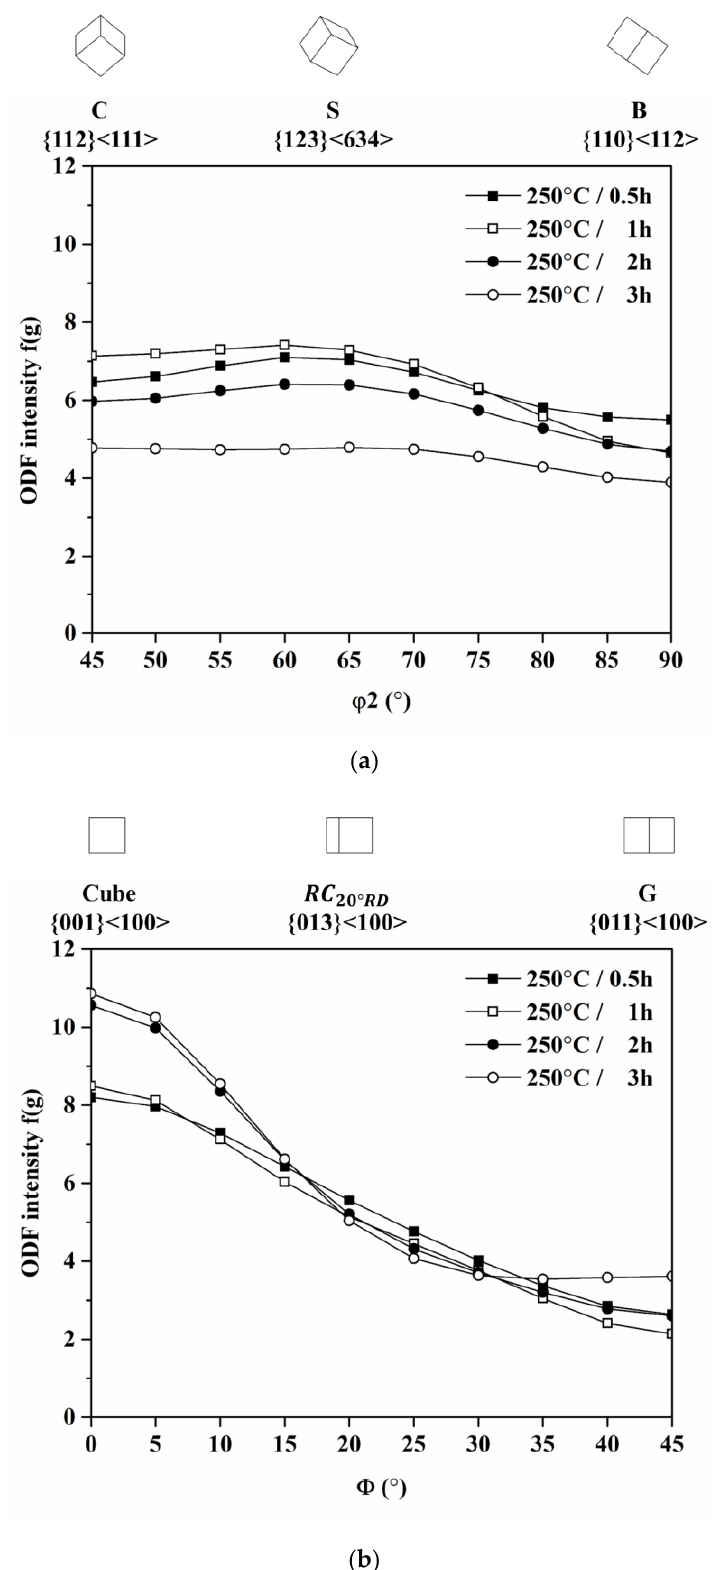
Figure 7. Distribution of orientation intensity along ( a ) β -fiber and ( b ) Cube-Goss fiber of AA5151 alloy at 250 ◦ C for 0.5, 1, 2, and 3